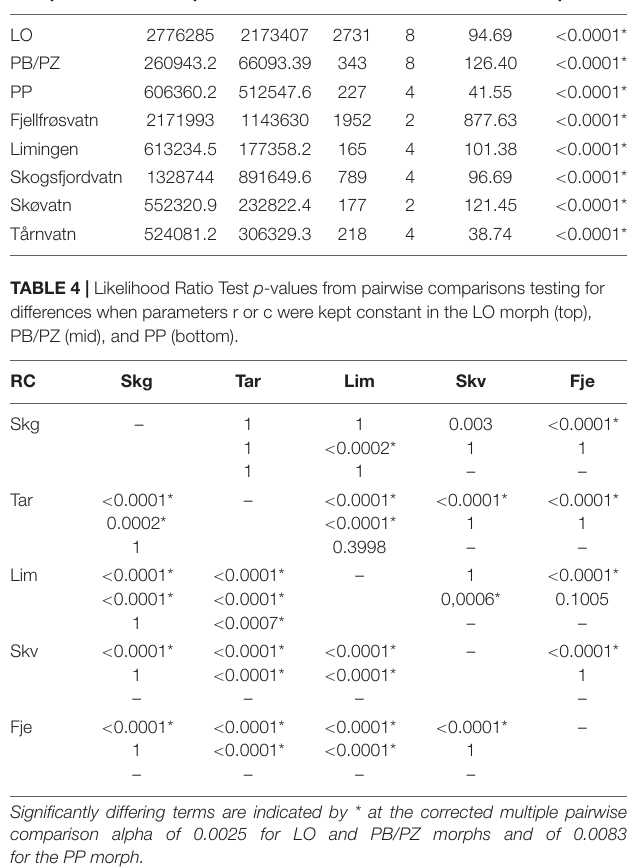
TABLE 3 | Analysis of residual sum of squares comparing the overall incidence of curves modeled by the bi-phasic growth model within morph type across all lakes (LO, PB/PZ, and PP) and among morphs within lake.